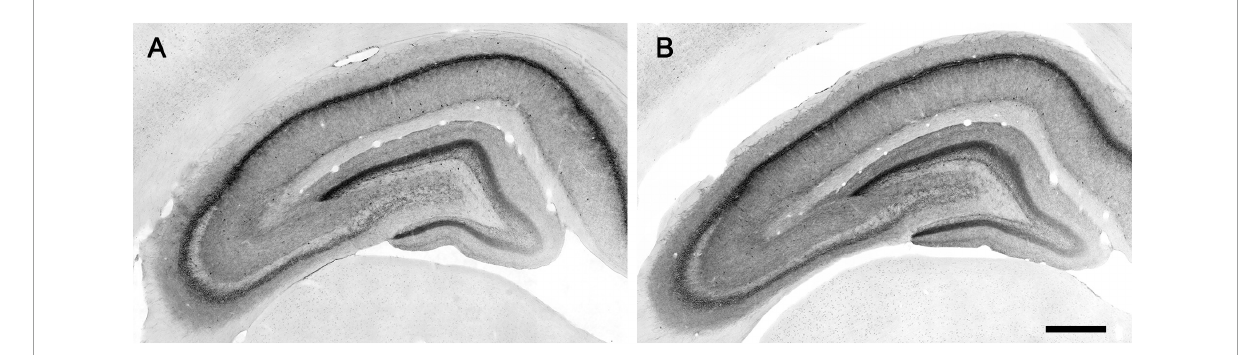
FIGURE5 Micrographs of CB 1 -immunostaining in the hippocampal formation of lean (A) and obese (B) Zucker rats processed in parallel. Scale bar = 500 µ m.